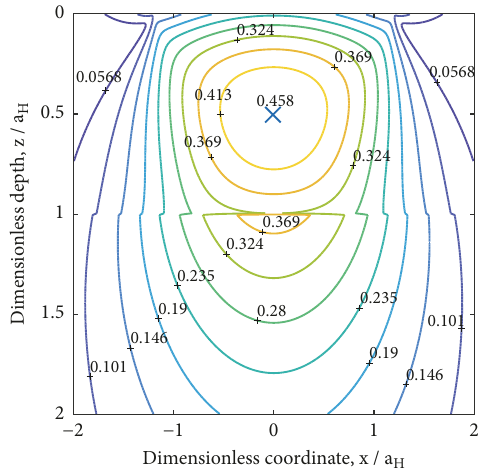
Figure 13: Iso-contours of dimensionless von Mises equivalent stress 𝜎 𝑉𝑀 /𝑝 𝐻 in the plane 𝑦 = 0 , ℎ/𝑎 𝐻 = 1 , and 𝐸 1 /𝐸 2 = 1/2 .